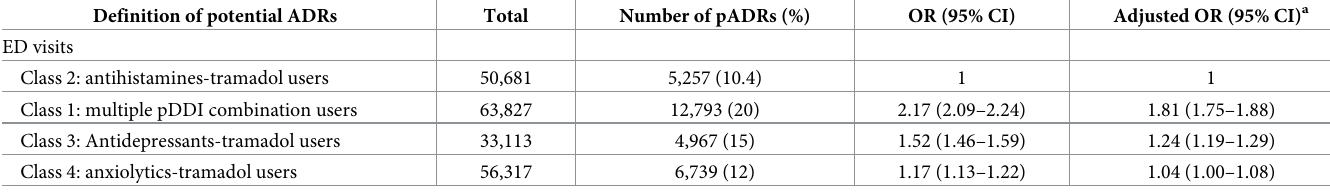
Table 3. Association between latent classes and potential adverse drug